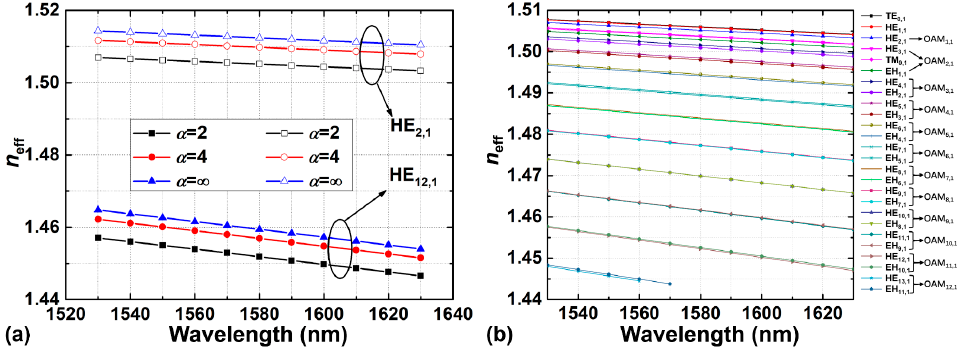
Figure 4. ( a ) Effective refractive indices of the HE 2,1 and HE 12,1 modes with α = 2, 4, ∞ ; ( b ) effective refractive indices of the eigenmodes when α = 2.